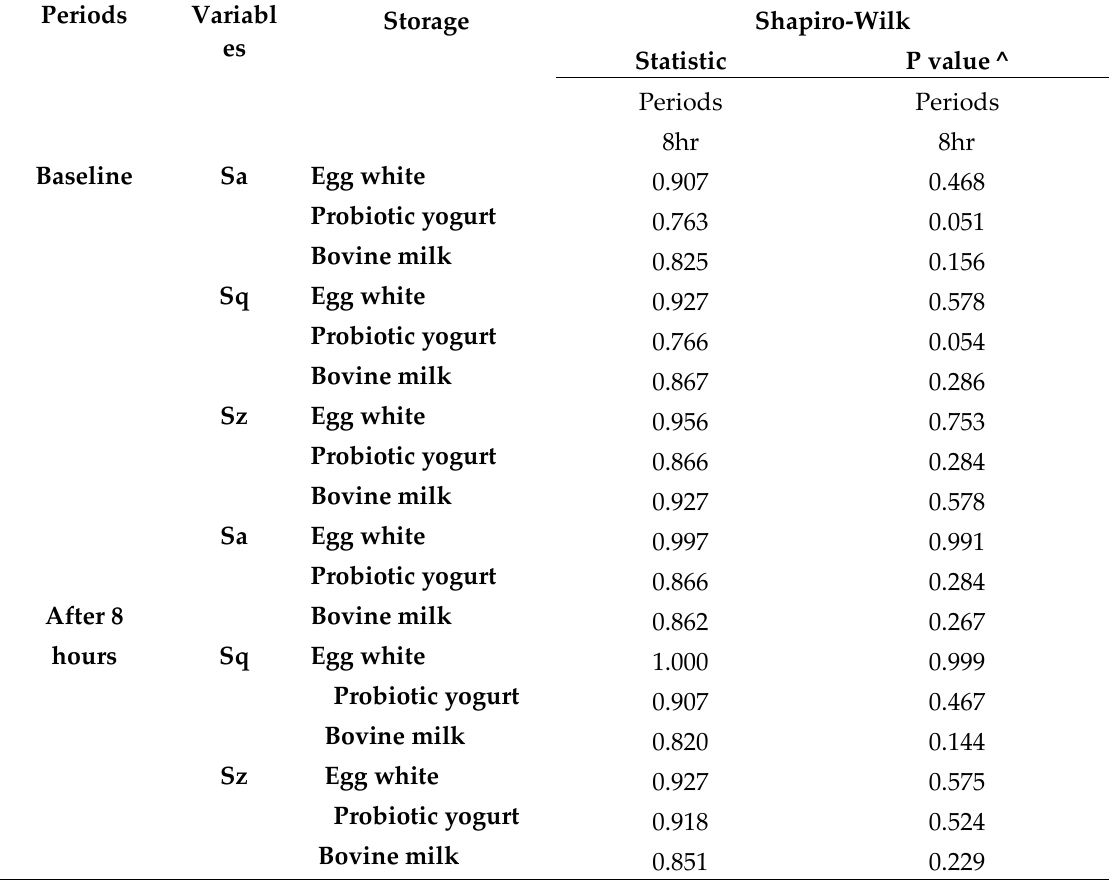
Table 2 : Normality test of roughness among storage media and periods Periods